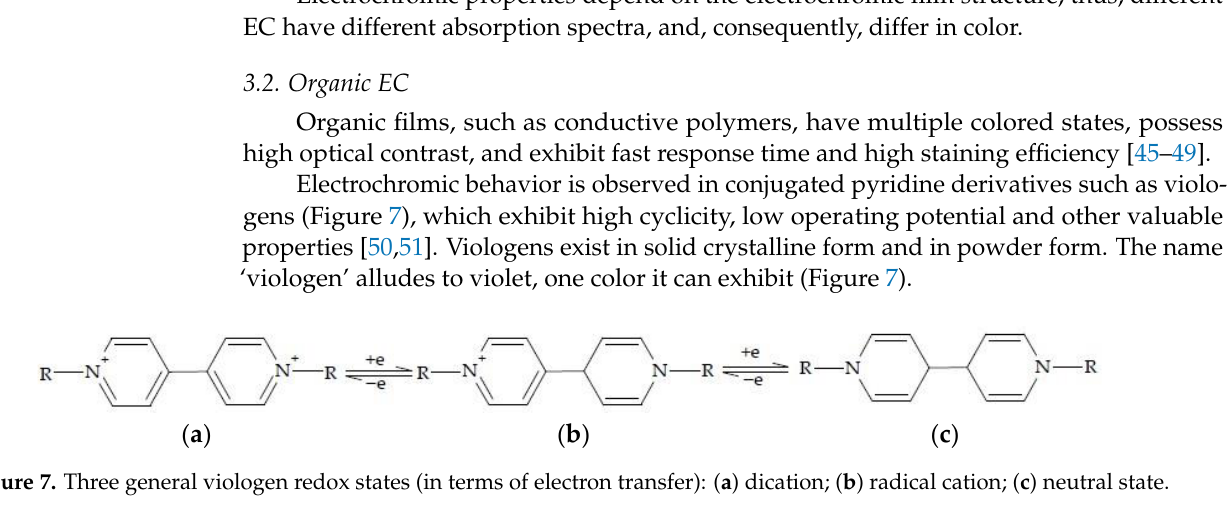
Figure 6. Interaction of radiation with an EC: ( a ) reflection; ( b ) absorption; ( c ) dispersion; ( d ) transmittance. Electrochromic properties depend on the electrochromic film structure; thus, different EC have different absorption spectra, and, consequently, differ in color.